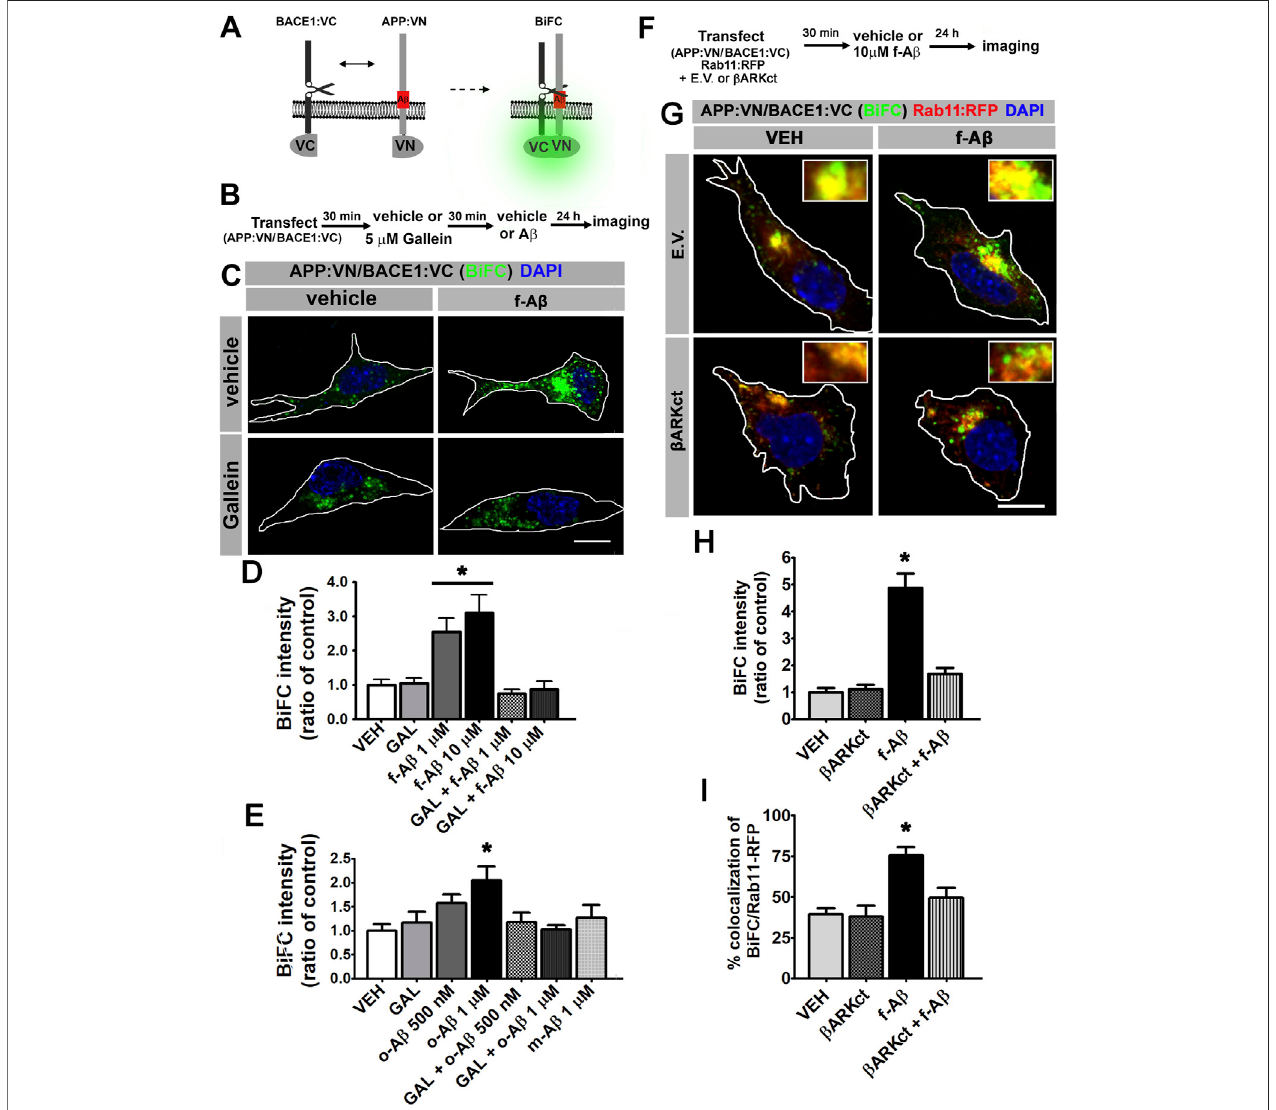
FIGURE 2 | Fibrillar and oligomeric A β enhance the physical interaction of APP and BACE1 through G βγ -dependent signaling in N2a cells. (A) . Scheme of bimolecular fl uorescent complementation (BiFC) system for detecting APP-BACE1 interaction. Interaction of APP and BACE1 fused to complementary fragments (VN and VC) of Venus fl uorescent protein reconstitutes fl uorescence. (B) . Experimental diagram for C-E. (C) . Representative fl uorescent images of BiFC in N2a cultures co- transfected with plasmid encoding to APP:VN and BACE1:VC and treated under the indicated conditions. (D) . BiFC intensity expressed as ratio of control (n = 65; 8 – 19 cells for each condition) *: p < 0.001 vs. all other conditions by ANOVA followed by Fisher LSD post-hoc test. (E) . BiFC intensity expressed as ratio of control (n = 108;12 – 18cellsforeachcondition)*: p < 0.01vs.VEHandvs.o-A β 1uM+GALbyANOVAfollowedbyFisherLSD post-hoc test. (F) .Experimental diagramforG-I. (G) . Representative confocal fl uorescent images of BiFC and Rab11:RFP in N2A cells co-transfected with β ARK or empty vector; and treated with the indicated conditions. (H) . BiFC intensity expressed as ratio of control (n = 46; 10 – 13 cells for each condition) *: p < 0.05 vs. all other conditions by Kruskal – Wallis followed by Dunn post-hoc test. (I) . Manders coef fi cientsof colocalization ofBiFC and Rab11:RFP, expressed as percent (n = 44; 10 – 13cells for each condition). *: p < 0.01 vs. all other conditions by ANOVA followed Fisher LSD post-hoc test. In all cases data represent mean ± SEM. Scale bar is 10 μ m.